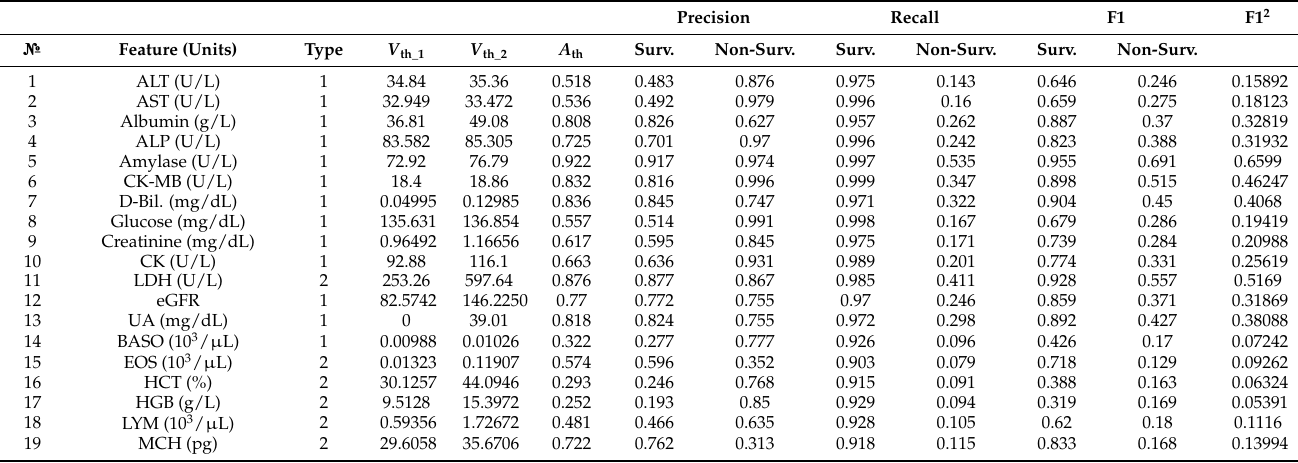
Table A3. Results of classification according to the two-threshold approach of surviving and non- surviving COVID-19 patients, for the balanced